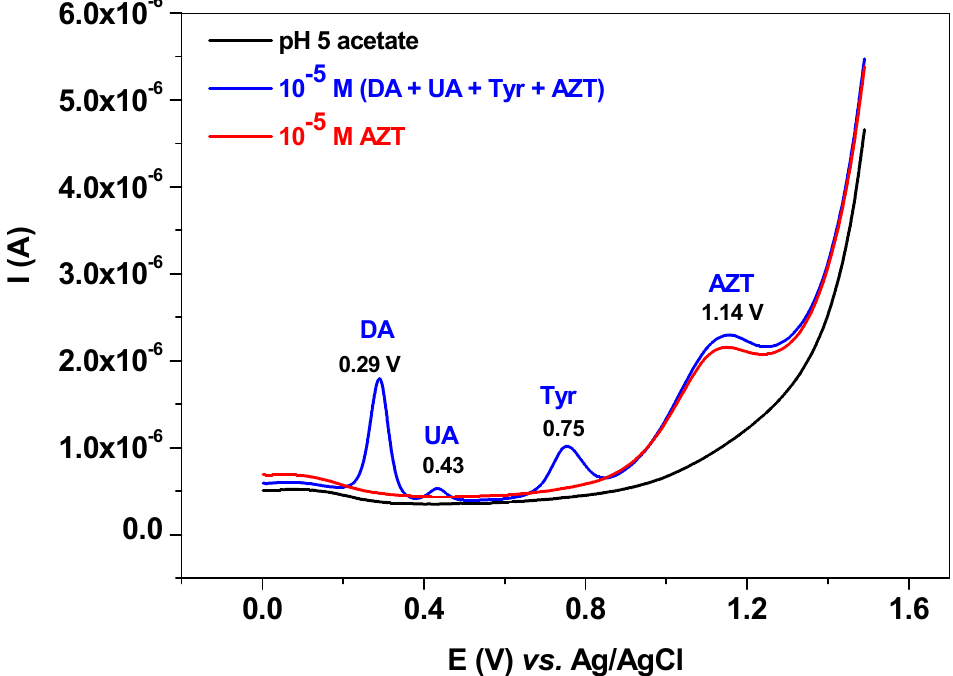
Figure 10. DPV signals recorded with EGr/GC electrode in pH5 acetate containing a single analyte (10 − 5 M AZT; red curve) and a mixture of analytes (DA + UA + Tyr + AZT; 10 − 5 M each; blue curve); 10 mV/s scanning